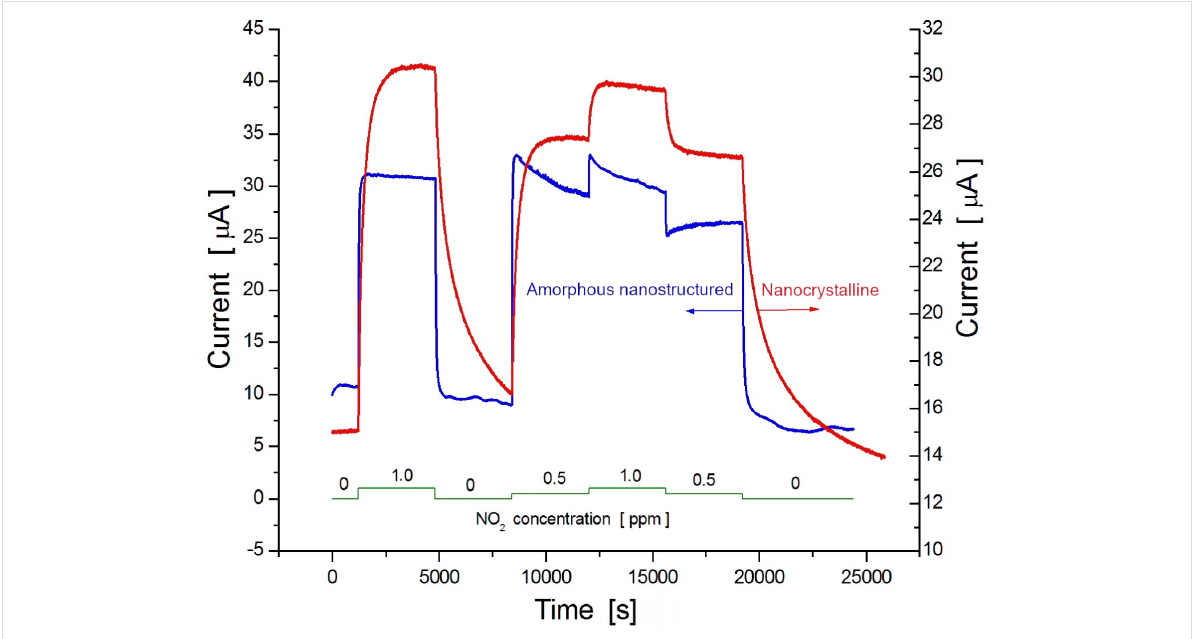
Figure 5: Transient characteristics of gas-induced current in amorphous nanostructured Te films (blue curve) at room temperature (22 °C) due to exposure to various concentrations of NO 2 , according to the profile shown by the green continuous line at the bottom. The transient characteristic profile for nanocrystalline film (red curve) is given for comparison.